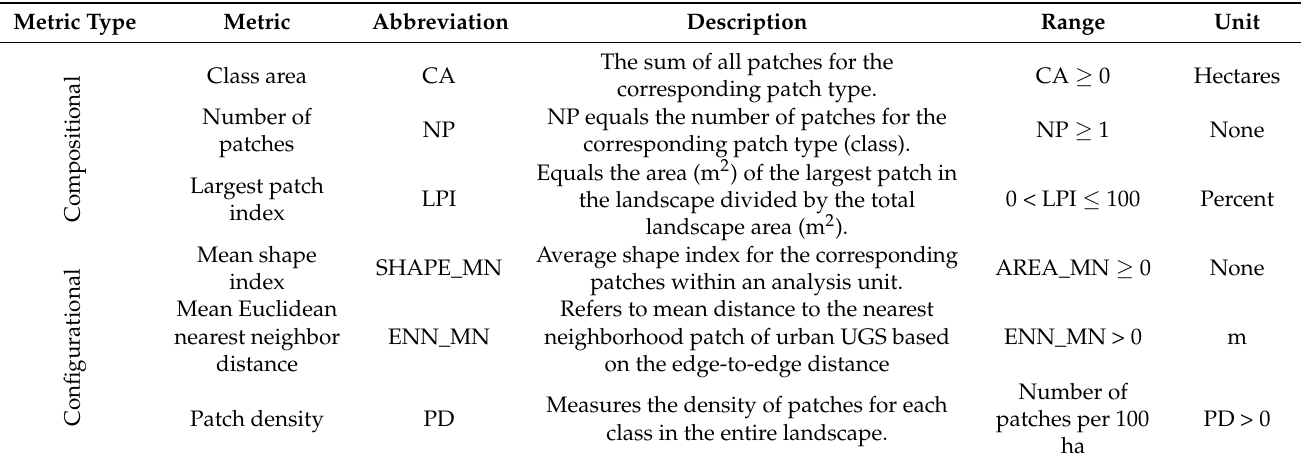
Table 3. Description of the spatial metrics used for the study (McGarigal et al.,